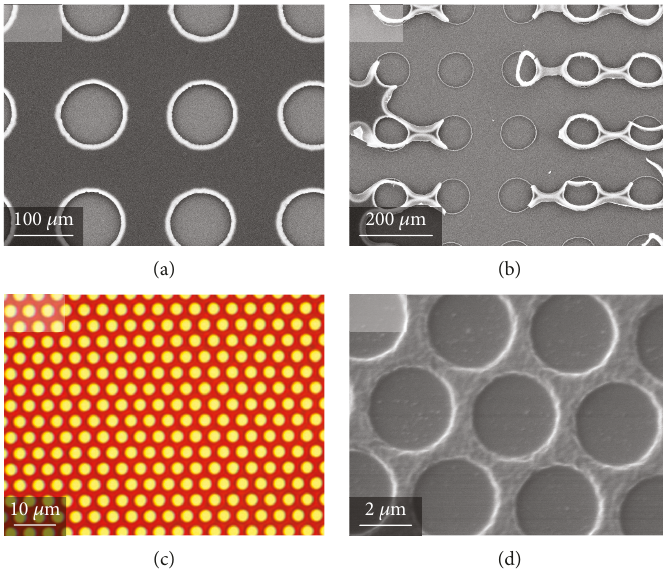
Figure 3: (a) SEM image of the complete negative pattern (i.e., open-hole array) of P3HT, distinctly formed at a high concentration of 3.00wt% using chloroform as a solvent. (b) SEM image of the negatively patterned P3HT layer formed at a concentration of 2.00wt% using chloroform as a solvent. The solution was expelled from the mold before completing the formation of the pattern, and accordingly, a small amount of P3HT was aggregated along the corners of the pillars in comparison with (a). (c) Optical microscopy image of an exemplary P3HT pattern fabricated using the PDMS mold with a smaller pillar array (of ~ 1 μ m thickness). A signi fi cant change in the overall tendency for the polymer patterning was not observed according to the size of the pillars. (d) SEM image of